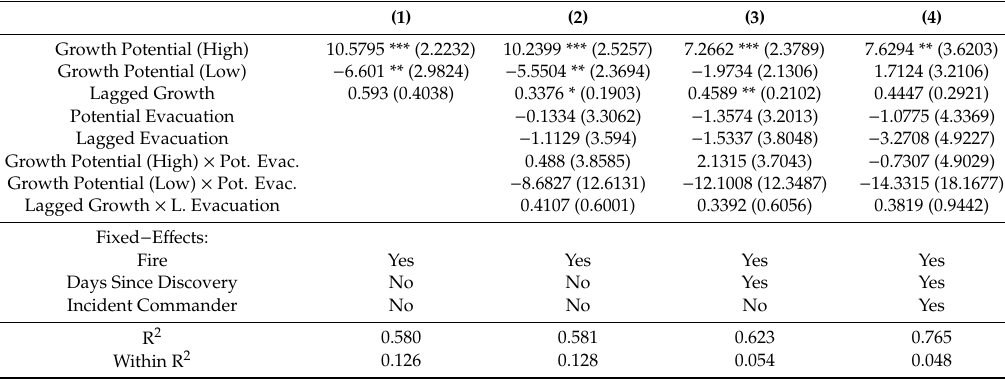
Table 4. Linear fixed e ff ects regression of total resource